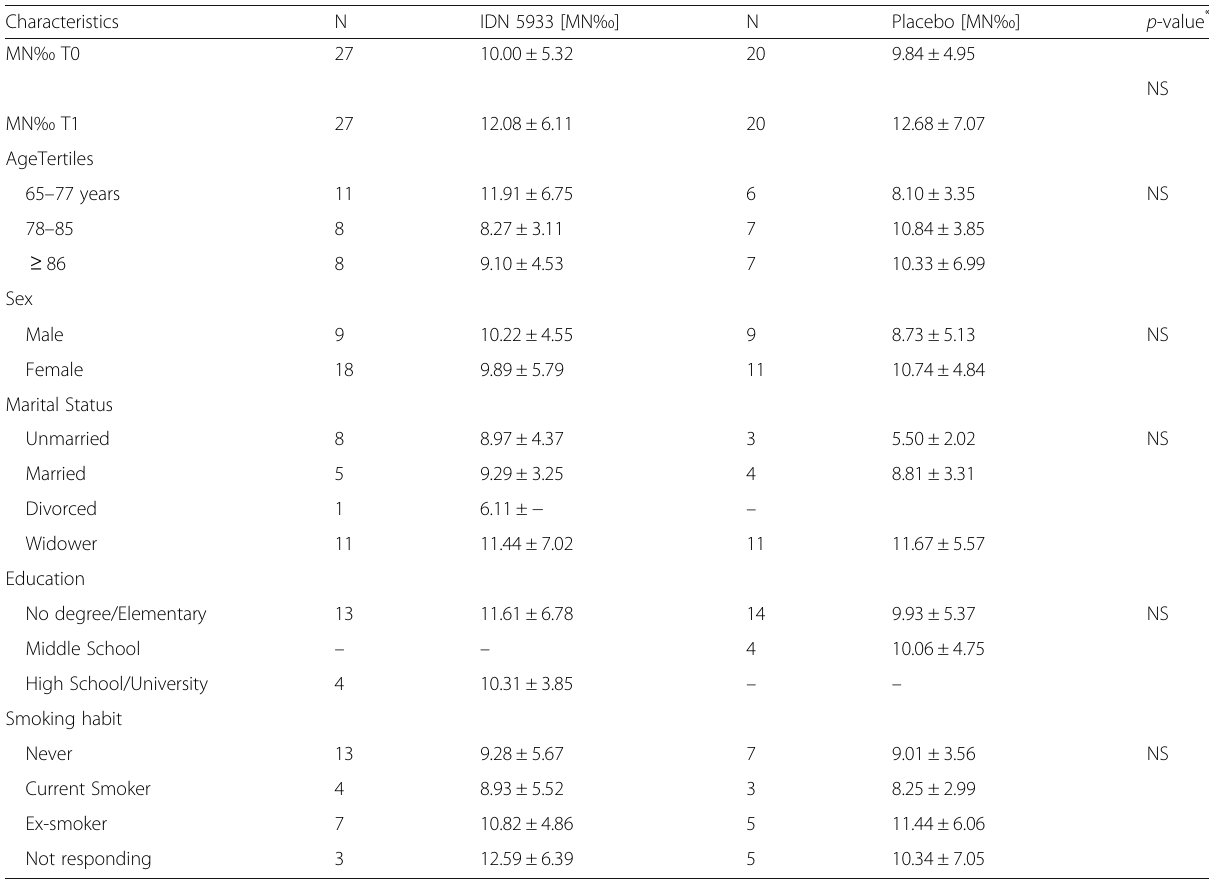
Table 3 Micronucleus frequency [Mean ± SD]according to main individual characteristics of participants to the GIBIEX study [values at T0]